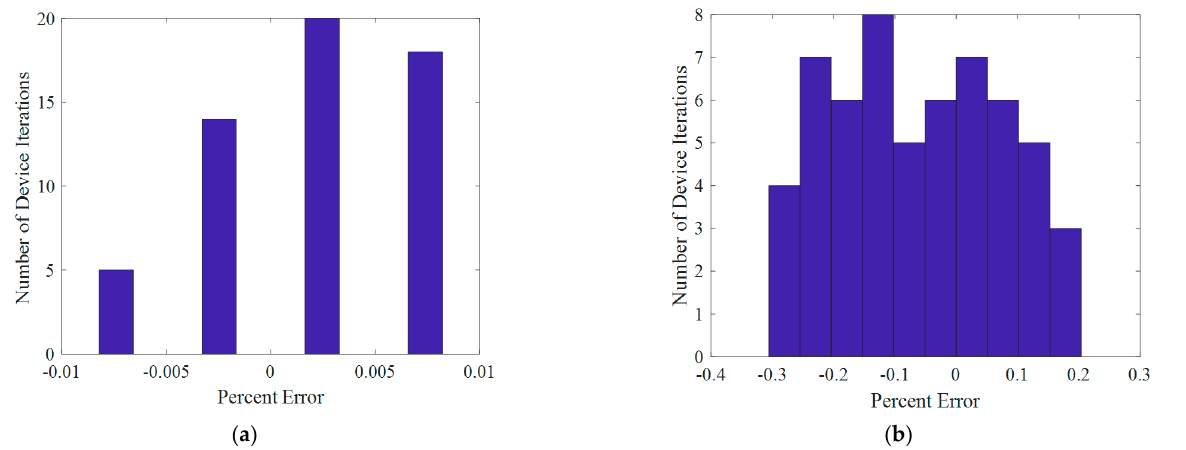
Figure 5. Histogram of the extraction error for: ( a ) thickness for all devices; ( b ) width for all devices.